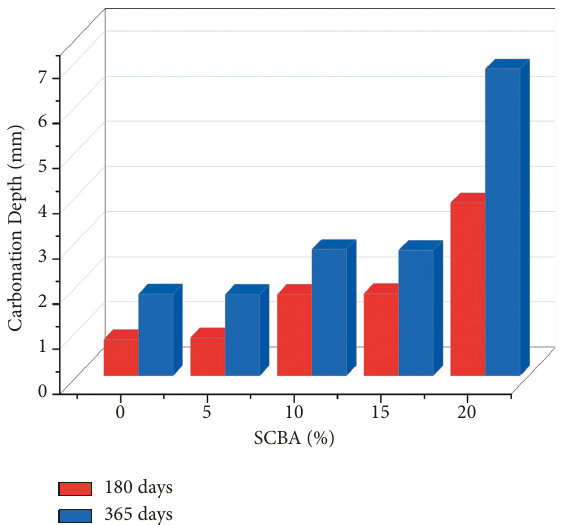
Figure 29: Carbonation depth of OPC-SCBA concrete [66].